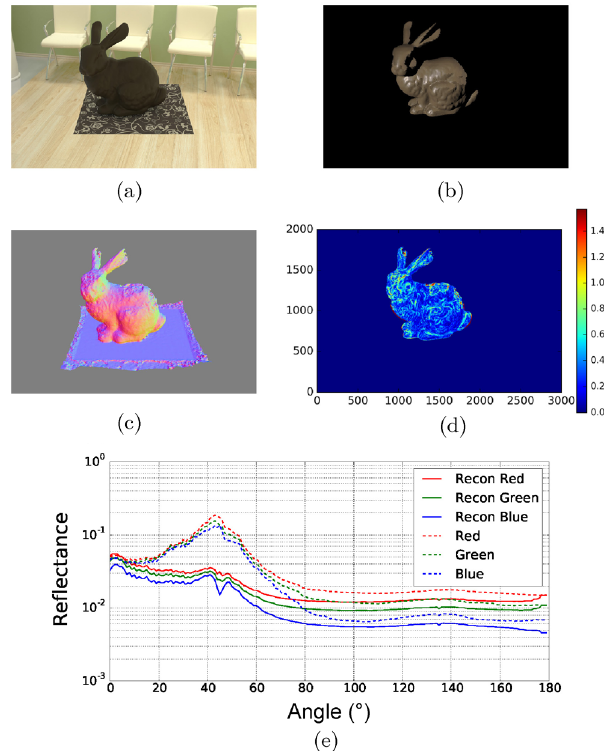
Fig. 4 (a) Example image captured with ambient lighting, for acquiring geometry. (b) Example image captured with a distant light, for acquiring reflectance. (c) Reconstructed normal map using PhotoScan . (d) Error map (in radian) of the angle between the reconstructed surface normal and ground truth. (e) Comparison to the ground truth (dashed line) of reconstructed BRDFs without considering surface normal error (solid